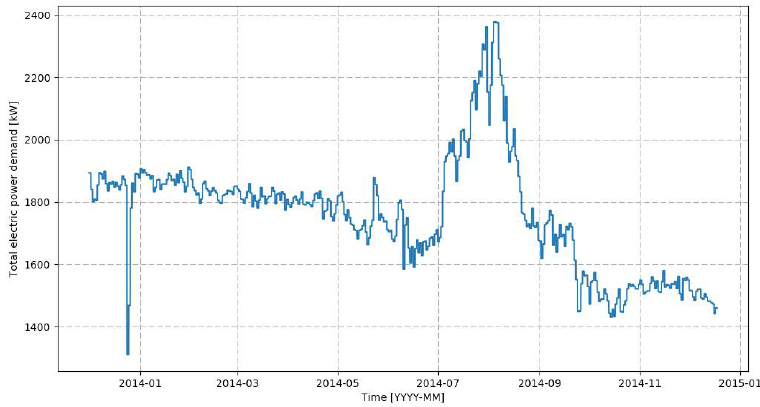
Figure A3. Total electric power demand versus time (Daily average).